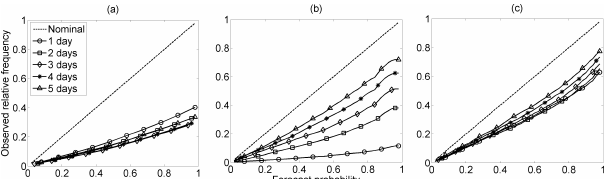
Figure 6. Reliability diagrams as a function of lead time for (a) dressed deterministic forecasts (b) forecasts based on meteorologi- cal ensembles and manual data assimilation and (c) forecasts based on meteorological ensembles, manual data assimilation and addi- tional perturbation of state